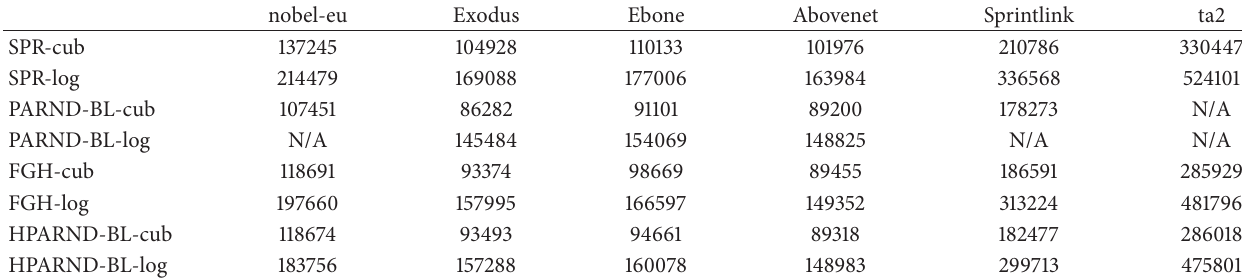
Table 8: Power consumption (W) versus topology— 𝑃 𝐶 V = 4 kW.